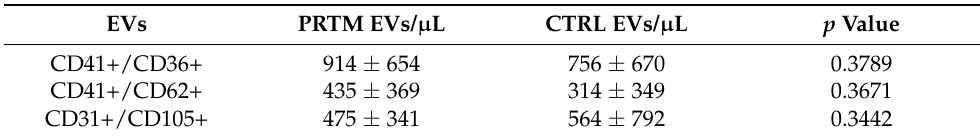
Figure 3. Counts of cord blood plasma large EVs plotted against newborn gestational age. ( A ) Platelet (CD41+CD36+), ( B ) activated platelet (CD41+CD62+), and ( C ) endothelial (CD31+CD105+) EVs in preterm newborns (PRTM; circles, n = 20) and control newborns (CTRL; squares, n = 10). Gestational age (GA) is in weeks. Red symbols represent hemolytic samples (Hb > 0.1 mg/mL). Table 2. EV counts in PRTM and CTRL presented as a mean ± SD. Differences between PRTM and CTRL groups were not significant.